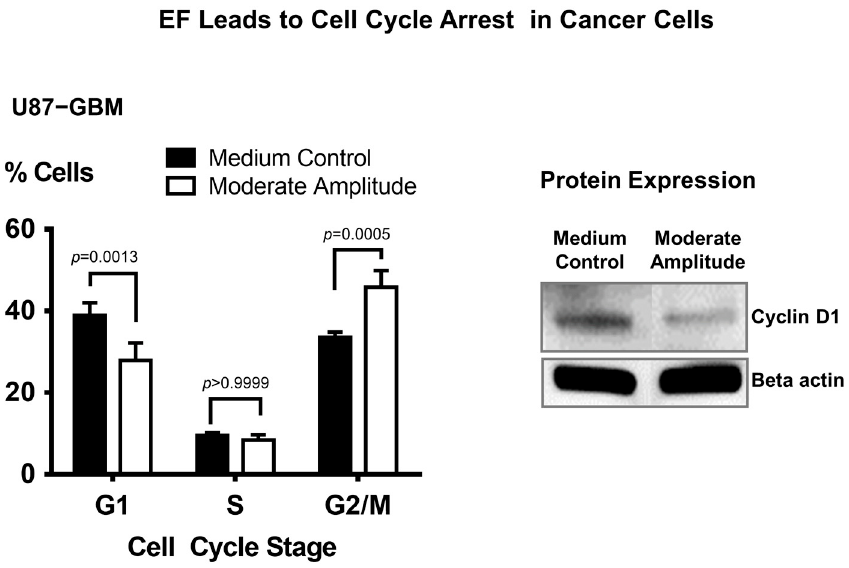
Figure 6. Moderate-amplitude electric field stimulation causes cell cycle arrest in glioblastoma cancer cells. Following EF stimulation of glioblastoma cells (U87-GBM) for 24 h, there was a significant change in the cell cycle distribution pattern (left panel), with lower percentage of cells in G1 and higher percentage of cells in G2/M phases in the EF groups as compared to the respective percentages in the control groups. Western blot analyses demonstrate that 24 h stimulation with moderate amplitude EF results in a decreased protein expression of cyclin D1 in glioblastoma cells (U87-GBM) (right panel). Sample size (n) = 3.